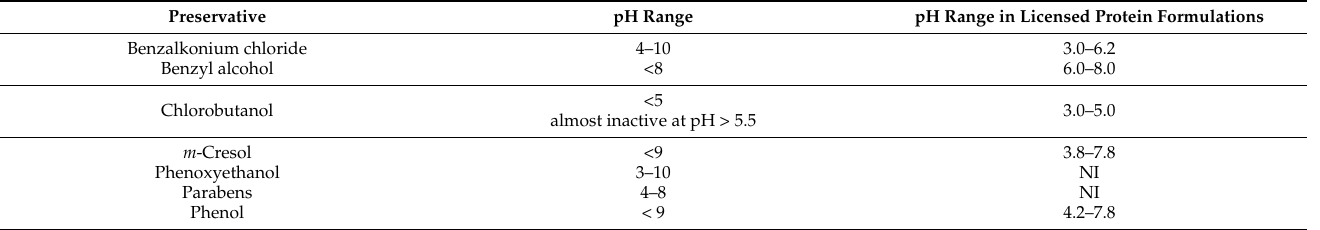
Table 6. pH spectrum for optimal antimicrobial activity of preservatives (left) [12,14] and pH range [13,14,74] found in already licensed protein formulations (right).